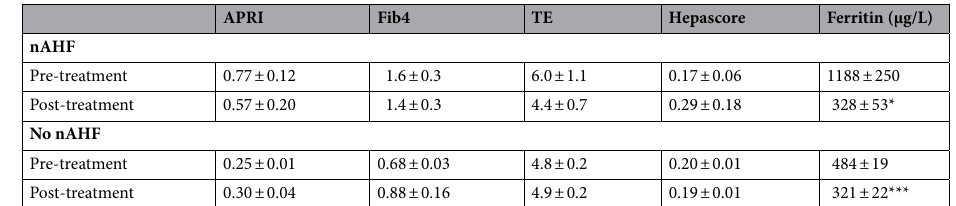
Table 5. Comparison of noninvasive biomarkers pre- and post-treatment in the subjects with either noninvasive biomarker-detected advanced hepatic fibrosis (nAHF) or no evidence of noninvasive biomarker- detected advanced hepatic fibrosis (no nAHF) using Model 2. Results are shown as mean ± SE. APRI: aspartate aminotransferase to platelet ratio index; Fib4: fibrosis-4; nAHF: noninvasive biomarker advanced hepatic fibrosis; No nAHF: no noninvasive biomarker advanced hepatic fibrosis; TE: transient elastography. *P < 0.05, ***P < 0.0001 compared with pre-treatment (paired t